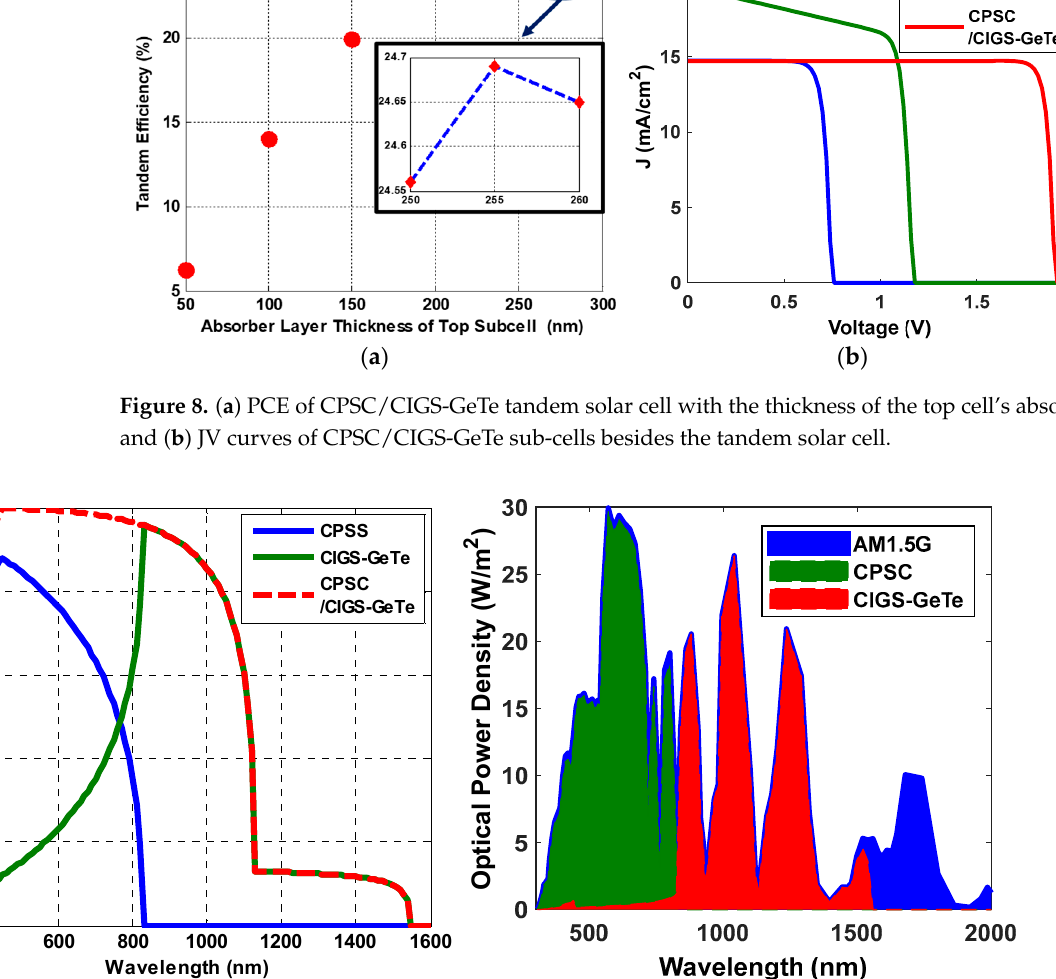
Figure 9. ( a ) EQE curves of CPSC/CIGS-GeTe sub-cells and tandem solar cell, and ( b ) the absorbed spectrum of AM1.5G by the CPSC/CIGS-GeTe tandem solar cell.